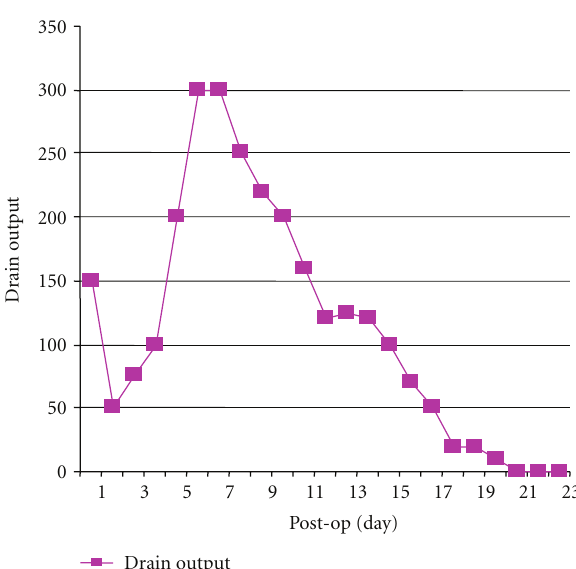
Figure 1: Daily postoperative drain output of Patient number 1.